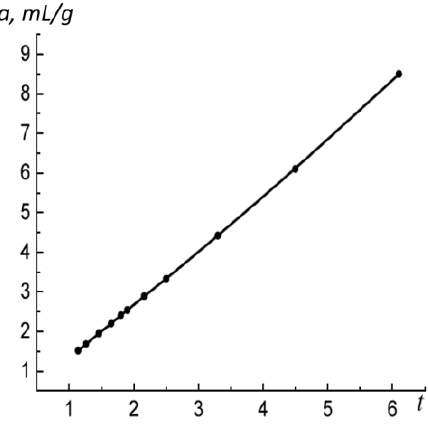
Figure 2. t-curve for N 2 gas adsorption isotherm of coal sample (BD3).